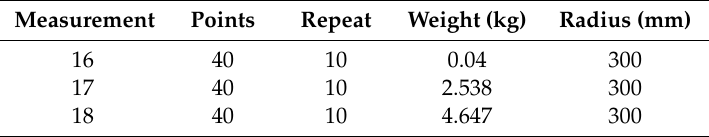
Table 7. Parameters for measurements of the influence of the payload.